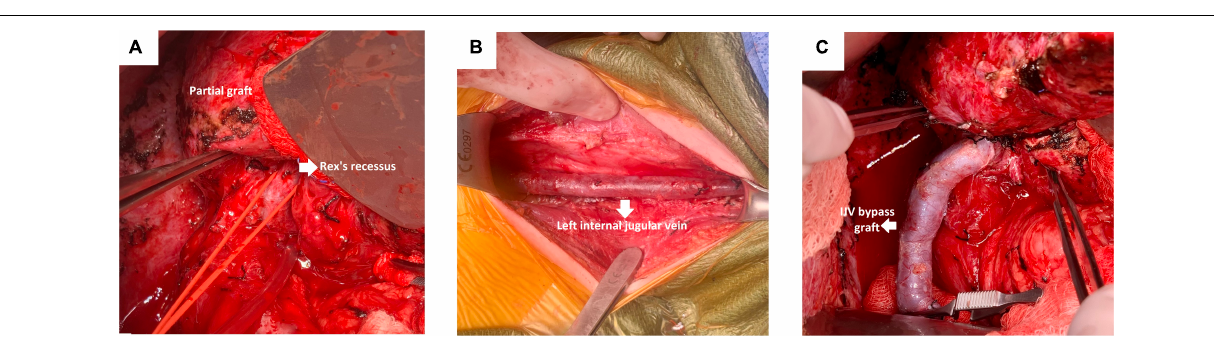
FIGURE 2 | Important steps during an MRB creation. (A) Identification of the hilar structures. (B) Exposure of the left IJV. (C) Anastomosis of the left portal vein and proximal end of the left